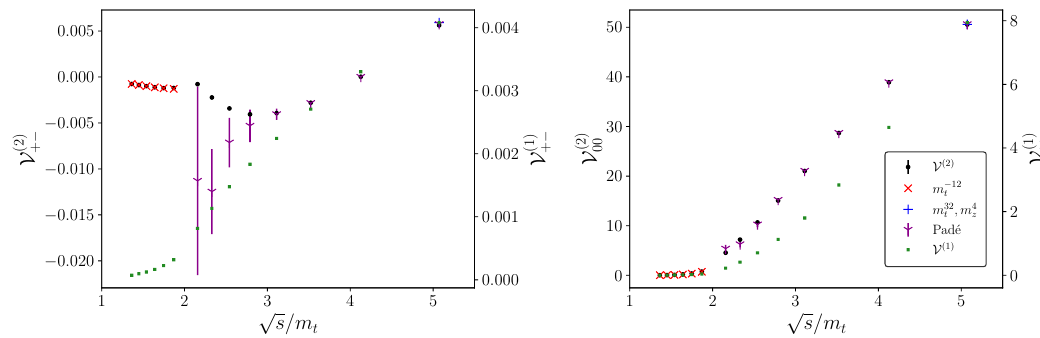
√ Figure 13. The s dependence of 1-loop and 2-loop interferences for polarised ZZ production in gluon fusion at cos( θ ) = − 0 . 1286 . Here we reproduce the top left and bottom right panels of figure 9 using Catani’s original subtraction scheme [117].